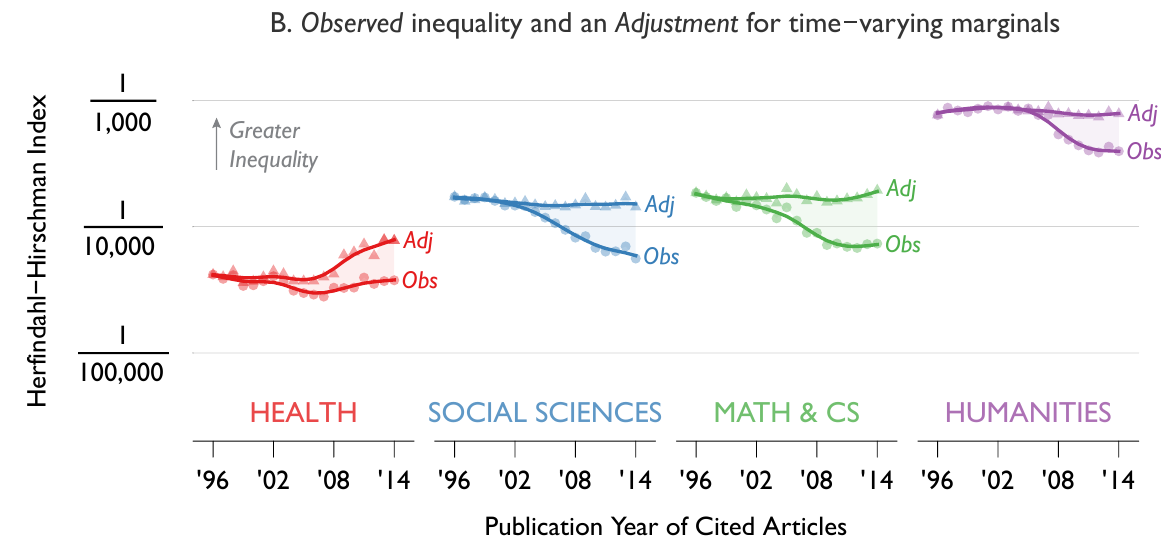
Figure 7: Herfindahl-Hirschman index (HHI) of citations within two years of publication, 1996–2014: Monte Carlo simulation and empirical results. Notes : The lines in the top panel marked Sim show the HHI of citation concentration from Monte Carlo results for hypothetical articles and citations designed to have a fixed pattern of inequality across years and fields, but total articles and citations matching the empirical marginals of those fields by year. The lines marked Cor remove the marginals bias in HHI using a resampling correction. The lines marked Obs in the bottom panel shows HHI over fields and time using the empirical data from Web of Science; these results are subject to marginals bias from differences in total articles and citations by field and year. Lines marked Adj adjust for marginals bias in the empirical data by resampling to the marginals in 1996 by field. Corrections and adjustments are omitted for the humanities in 1997–2002. All curves are smoothing splines with a span of 0.5. One exceptionally highly cited article in mathematics and computer science is